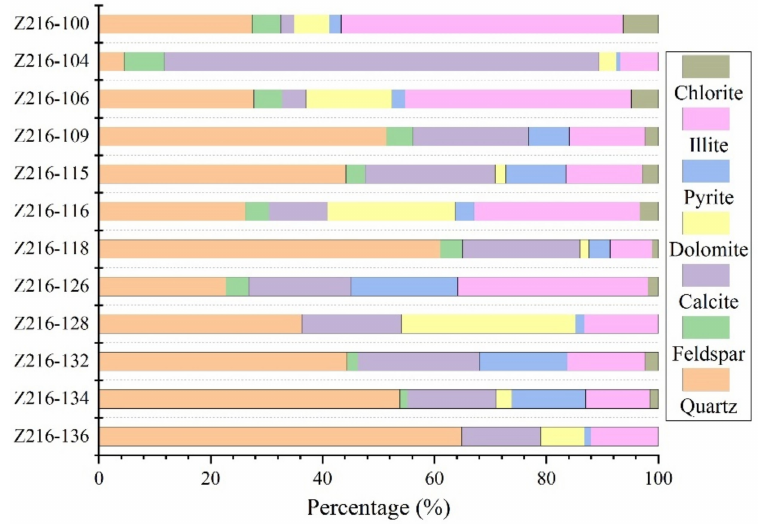
Figure 2. Mineral compositions of the studied deep shales from the Luzhou Block.